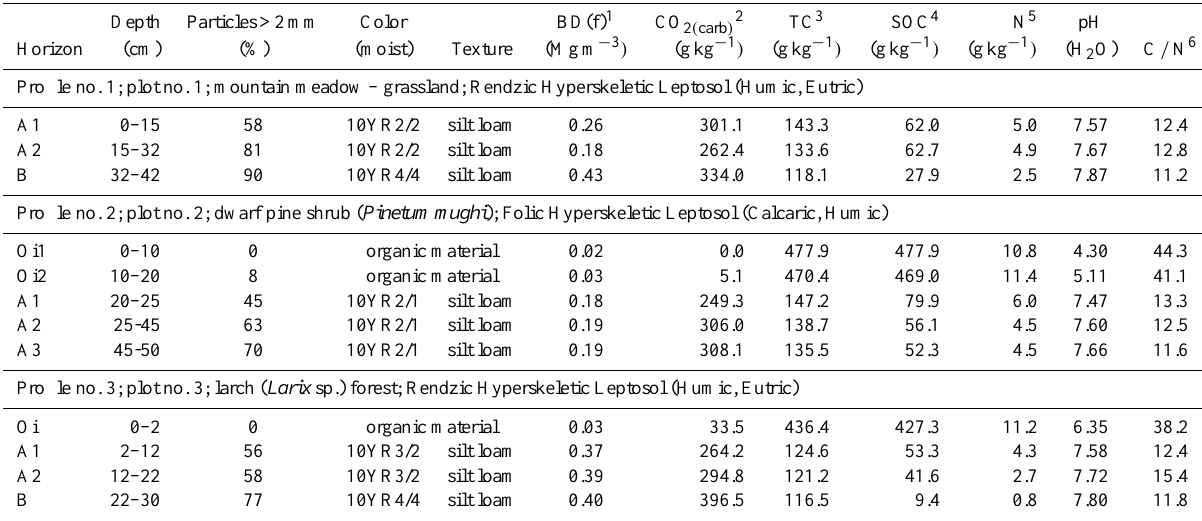
Table 1. Basic properties of reference soil profiles.